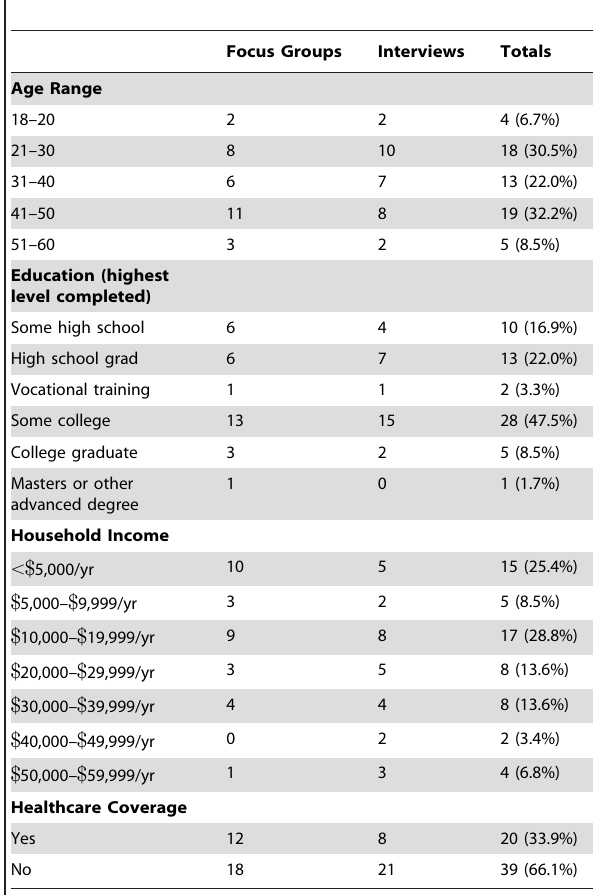
Table 1. Demographic Characteristics of Qualitative Study